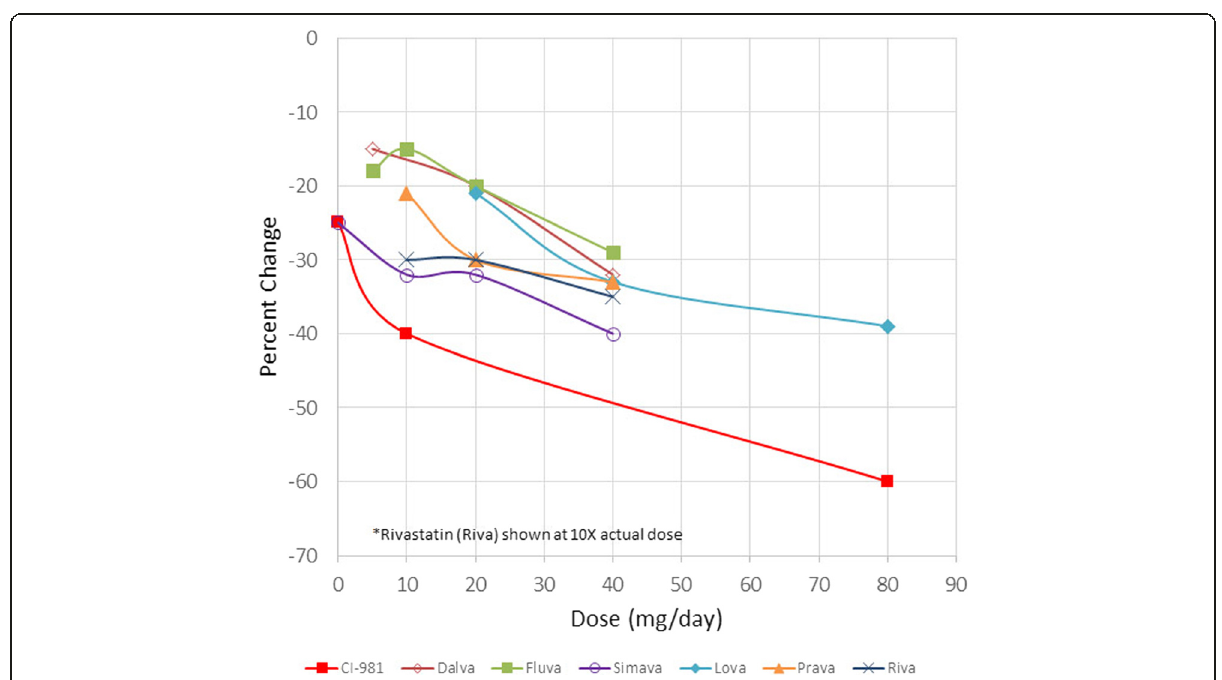
Fig. 9 Atorvastatin (CI-981) Phase II results compared with marketed products (adapted from Ref (Lie